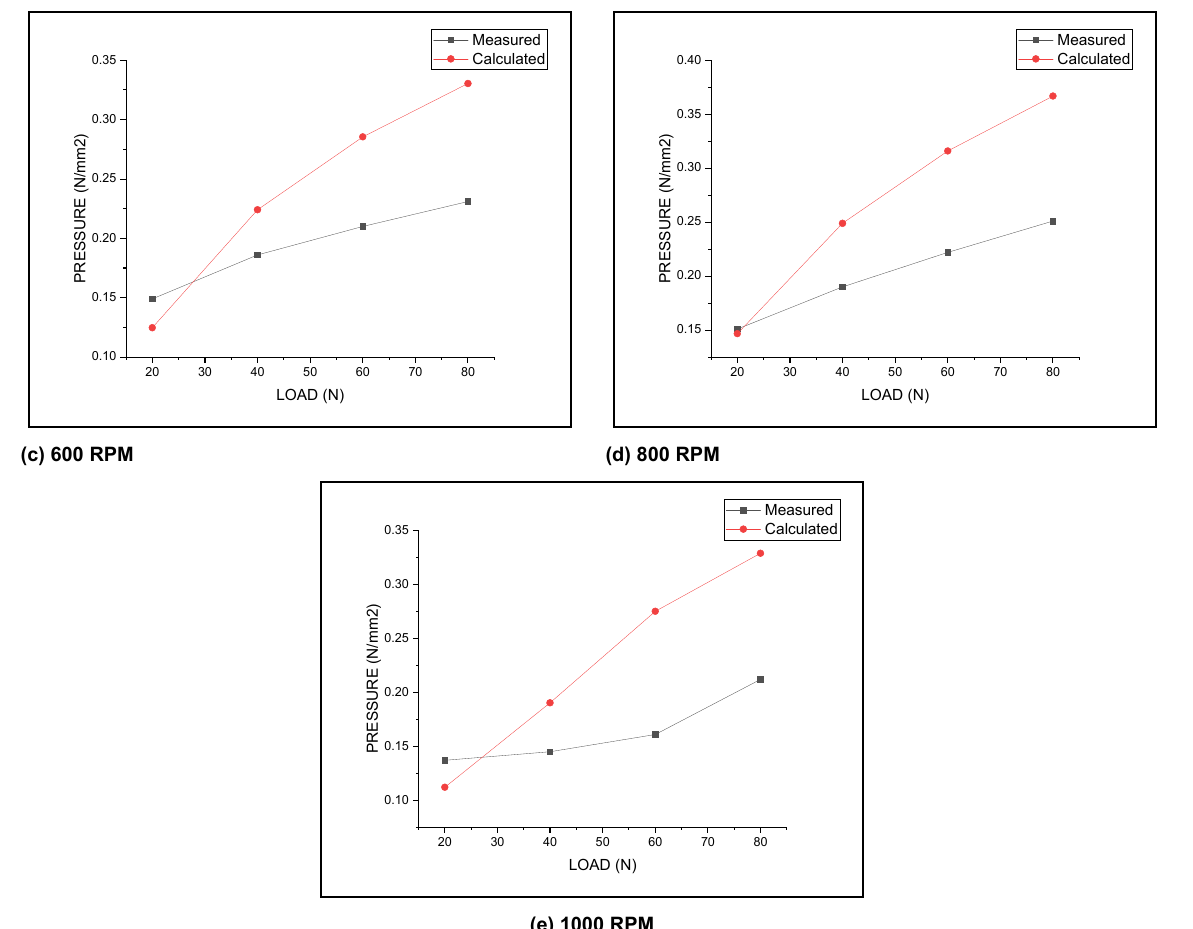
Figure 14. Comparison of interface pressure for various loads at constant